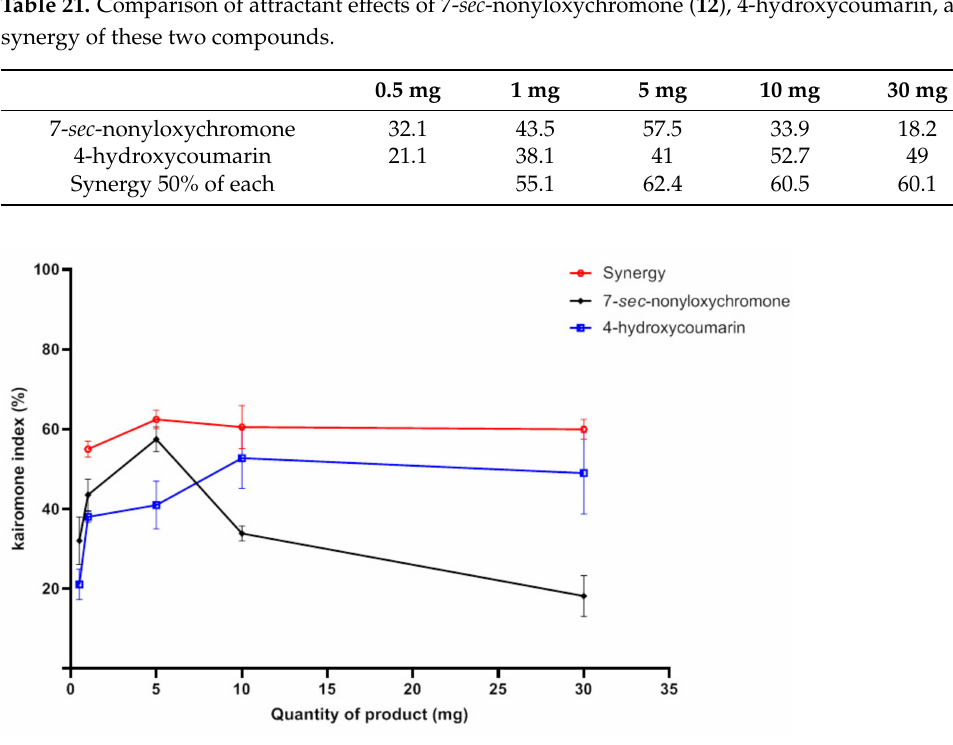
Figure 8. Attractant effects (SD) of 7- sec -nonyloxychromone, 4-hydroxycoumarin, and their combina- tion on Aedes albopictus